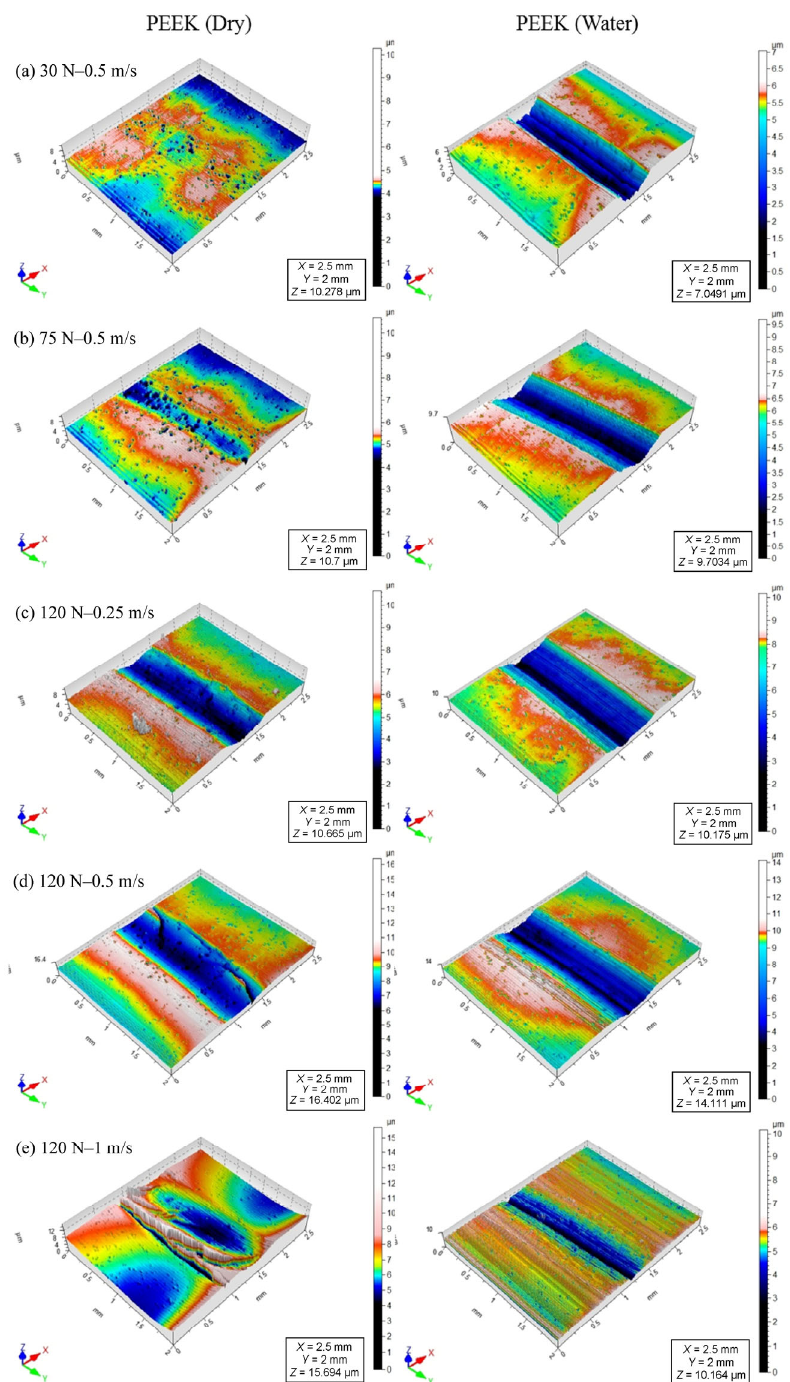
Fig. 9 3-D surface topography of PEEK materials after tests under different